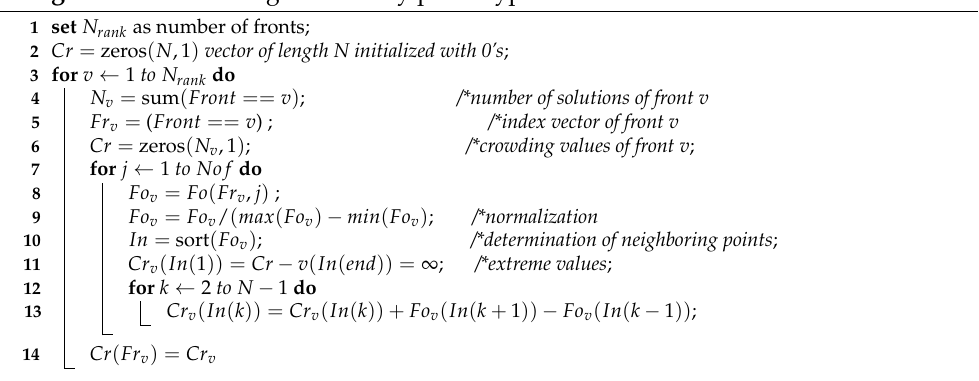
Algorithm 2 Crowding distance by